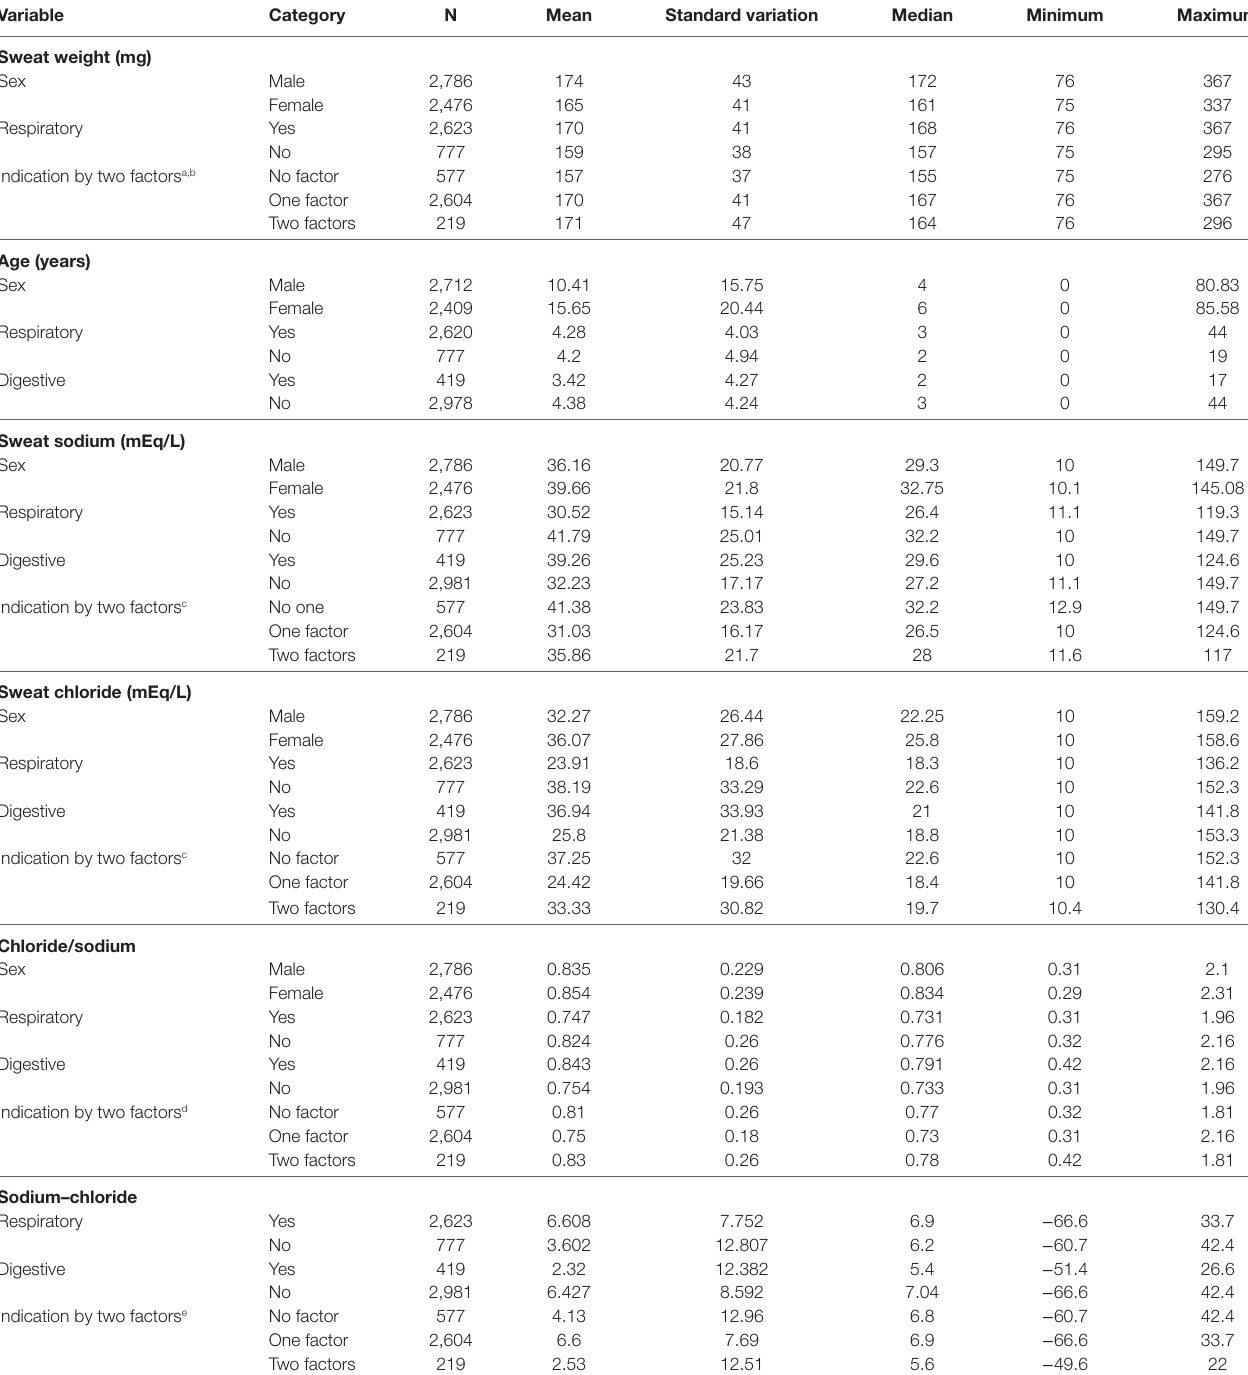
Table 3 | Association between sweat weight, sex of the subjects, sweat chloride, sweat sodium, and reason for indication of sweat test. Variable category n Mean standard variation Median Minimum